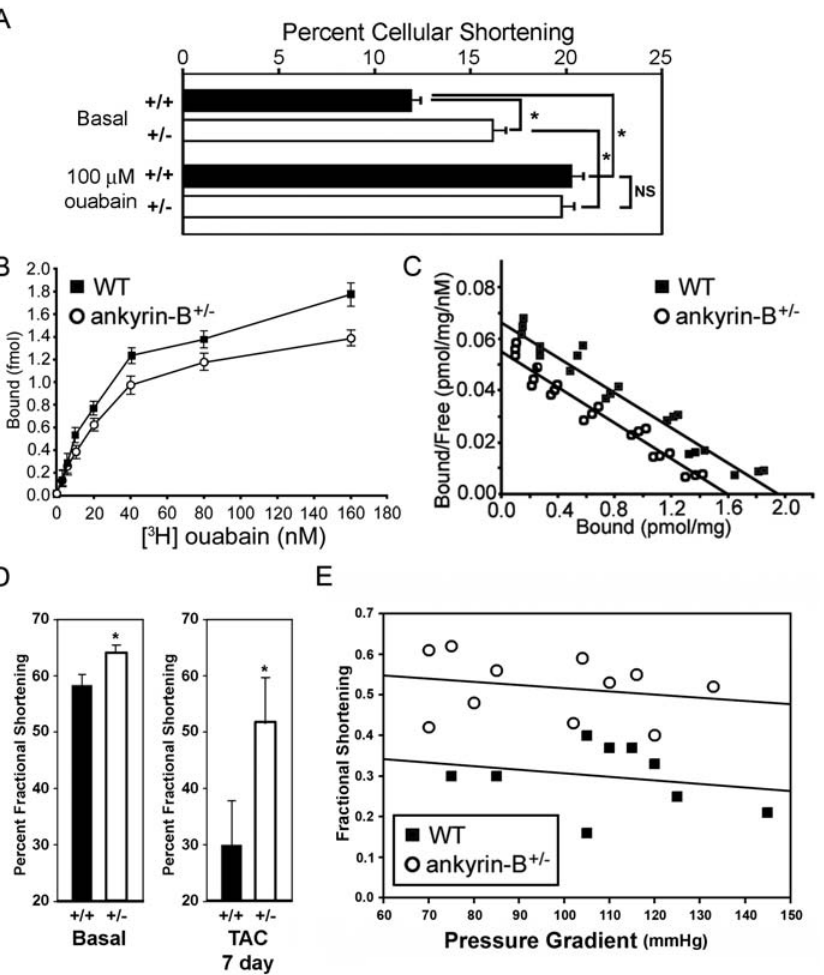
Figure 2. Loss of ankyrin-B-dependent [ 3 H]-ouabain-binding sites mimics the cellular action of digitalis. ( A ) Isolated unloaded ankyrin-B + / 2 ventricular cardiomyocytes display increased cellular shortening compared to unloaded WT cardiomyocytes, consistent with increased [Ca 2 + ] i transients [14]. Asterisk represents p , 0.01 between untreated WT and ankyrin-B + / 2 cardiomyocytes (15–20 cardiomyocytes from 4–5 mice). WT and ankyrin-B + / 2 cardiomyocytes treated with maximal doses of ouabain (100 m M) display significant elevations in cellular shortening compared with untreated WT and ankyrin-B + / 2 cardiomyocytes (15–20 cardiomyocytes from 4–5 mice, p , 0.01, asterisks). ( B–C ) Live, isolated ankyrin-B + / 2 cardiomyocytes display reduced ( , 20%) surface expression as measured by binding of [ 3 H]-ouabain (n=3, p , 0.01). ( D–E ) Conscious echocardiograms of wild-type and ankyrin-B + / 2 mice before and after transverse aortic constriction. Black labels represent wild-type animals, white labels represent ankyrin-B + / 2 data. Ankyrin-B + / 2 mice show preserved fractional shortening compared to wild-type mice over a wide range of hemodynamic stress (induced through transverse aortic constriction).